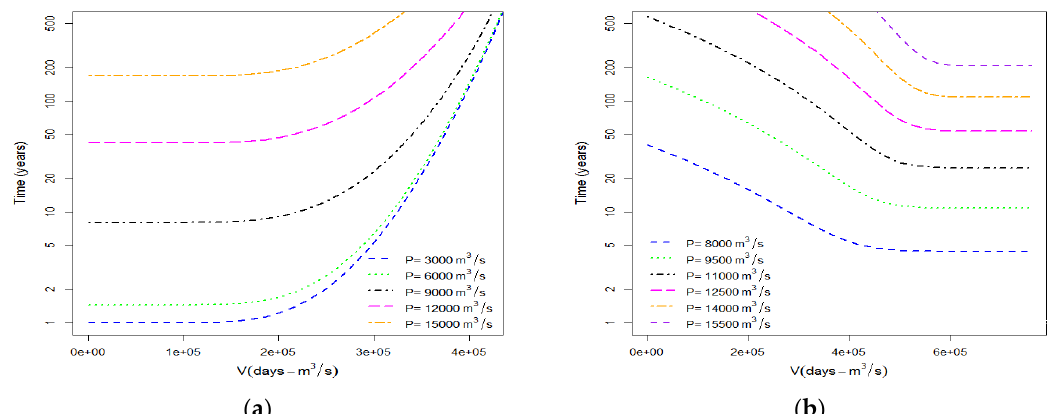
Figure 7. ( a ) Conditional return periods T ( V > v | P ≤ p ) , ( b ) Conditional return periods T ( V > v | P > p ) . Table 7. Primary and conditional return periods for copulas at the median and maximum values of P and V .